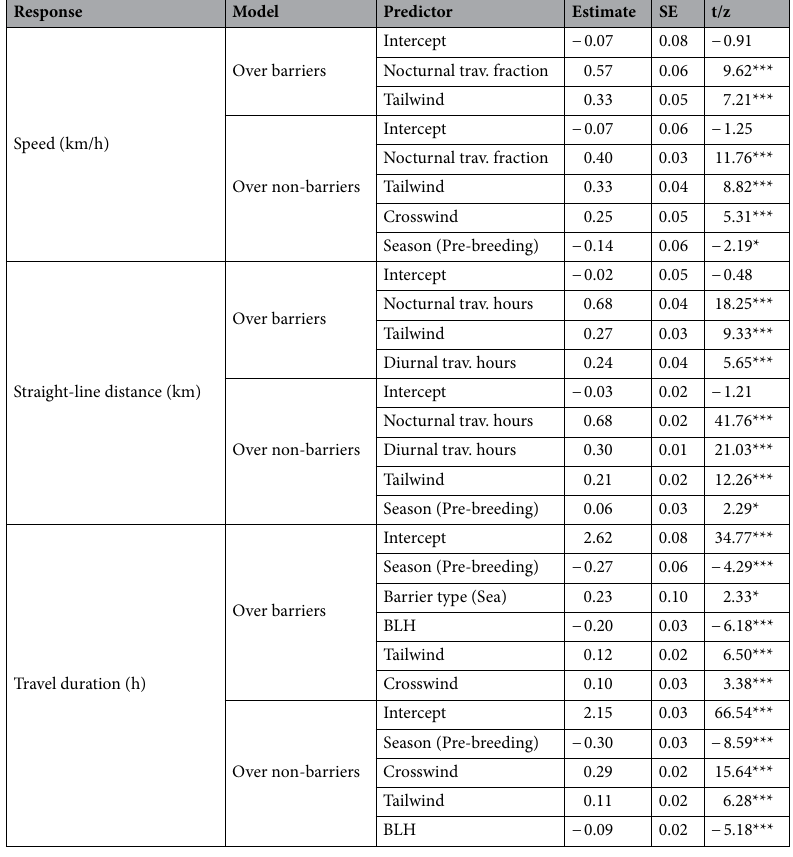
Table 1. Estimates for fixed effects on daily mean travel speed, travel straight-line distance and travel duration as estimated by the most parsimonious model when flying over barrier (sample size = 183 travel days) or non- barrier (sample size = 600 travel days) areas. The models for travel duration included the factor barrier type with two levels: sea and desert. Boundary layer height (BLH) serves as a proxy for the availability and strength of thermal uplifts. Model estimates in units of standard deviation (SD) (organised from higher to lower relative importance), standard error (± SE), and the t-value and z-value (the ratio between the estimate and its SE) are given. All models included individual identity (ID) as a random effect. (* p ≤ 0.05; ** p ≤ 0.01; *** p ≤